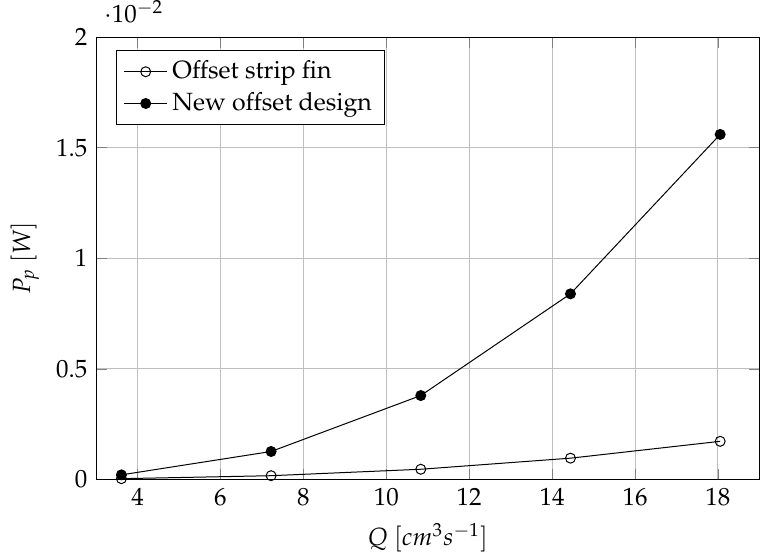
Figure 14. Pumping Power ( P p ) in different volumetric flow rates for conventional offset strip fin design and new offset